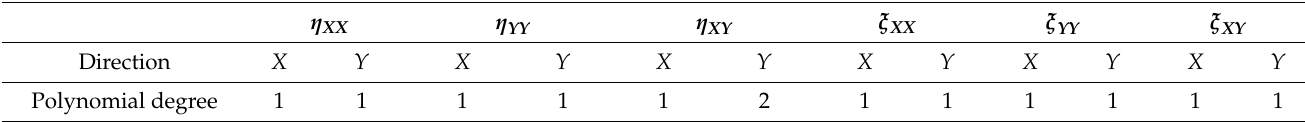
Figure 18 . Shear loading: ( a ) membrane strain 𝑒 (cid:3025)(cid:3026) and ( b ) normalized membrane strain 𝜂 (cid:3025)(cid:3026) , slice at Y = 250 mm.